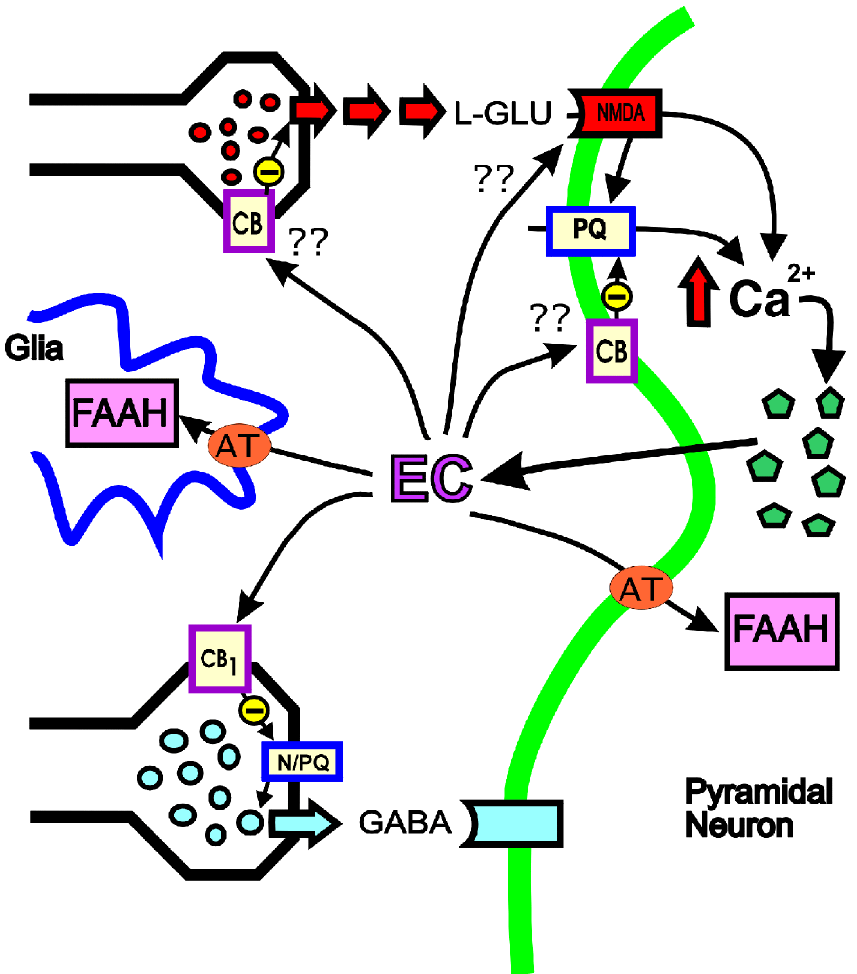
FIGURE 2 . A model for the actions of endocannabinoids in the hippocampus. Strong excitation of pyramidal neurons via the release of L-glutamate (L-Glu) is very effective at increasing intracellular Ca 2+ levels, involving both depolarization (N/PQ voltage-gated Ca 2+ channels) and activation of NMDA receptors. It is suggested that this stimulates the release of endocannabinoids (EC), which act in a retrograde manner on both inhibitory (via CB 1 receptors) and excitatory terminals (possibly involving a novel cannabinoid receptor, CB). The postsynaptic activation of voltage-gated Ca 2+ channels (PQ) and NMDA receptors may also be modulated. Endocannabinoids are removed by a transporter (anandamide transporter, AT), possibly into both neurons and glia, where they